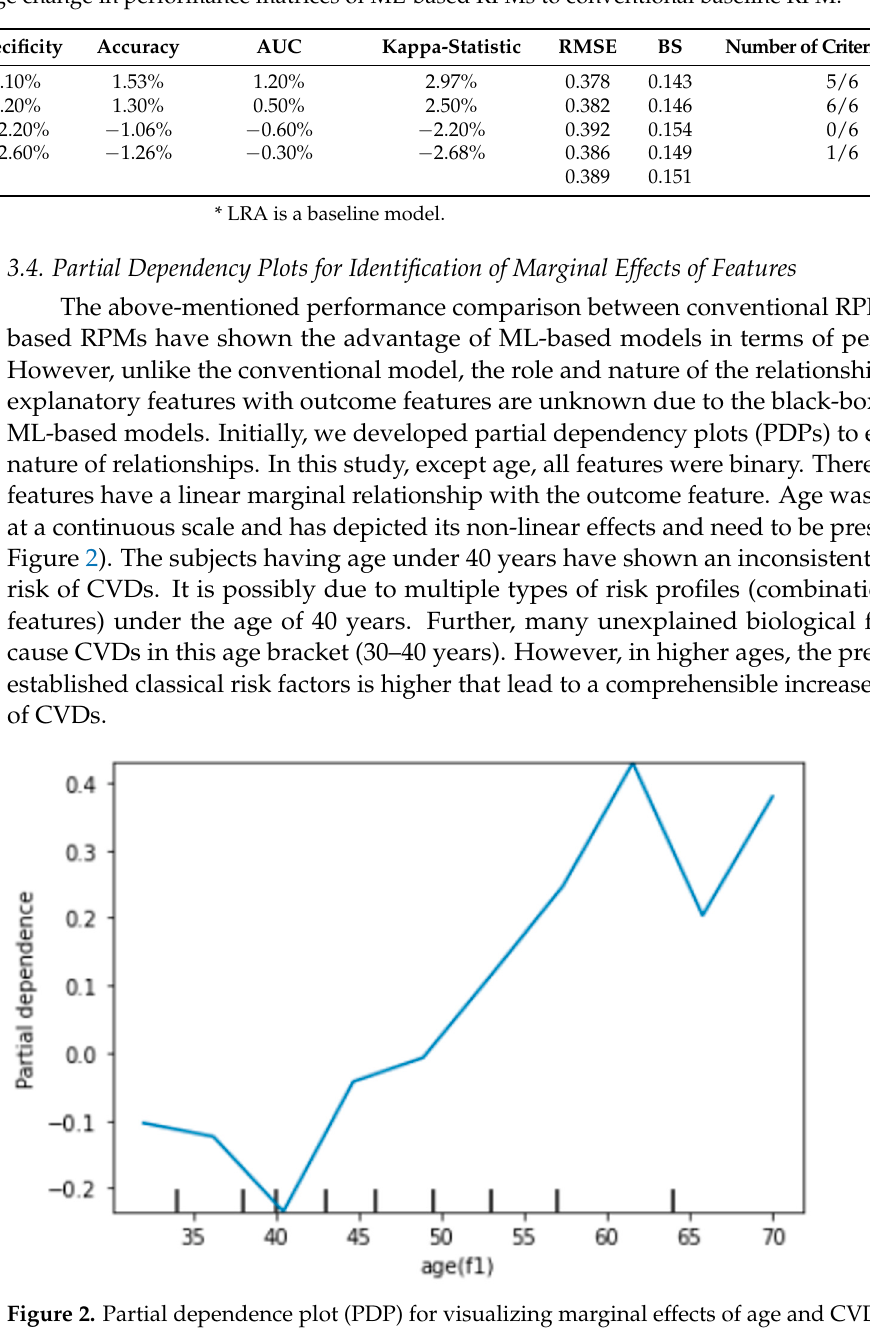
Figure 2. Partial dependence plot (PDP) for visualizing marginal effects of age and CVDs